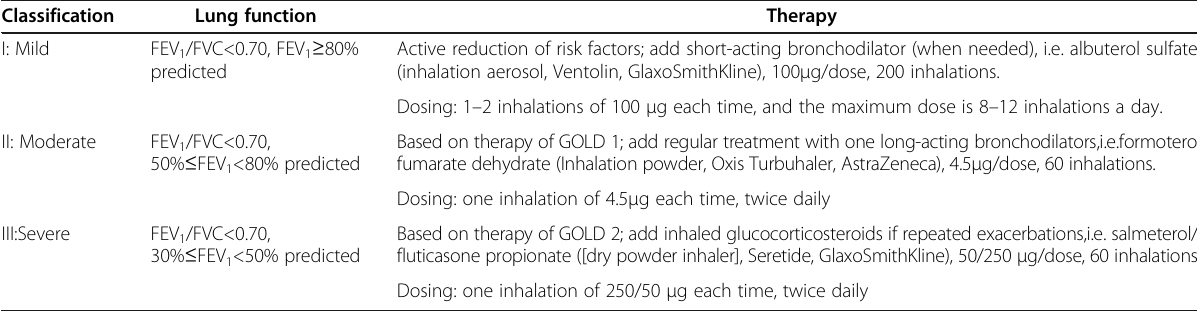
Table 1 Therapy at each stage of stable COPD Classification